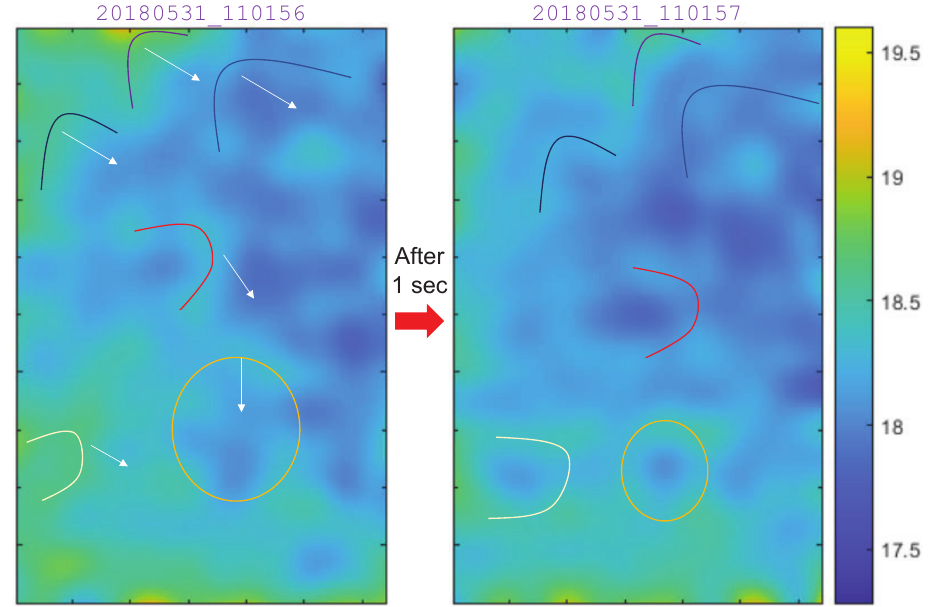
Figure 12. Indirect proof of air temperature measurement by air flow visualization. The arrows indicate the directions of air